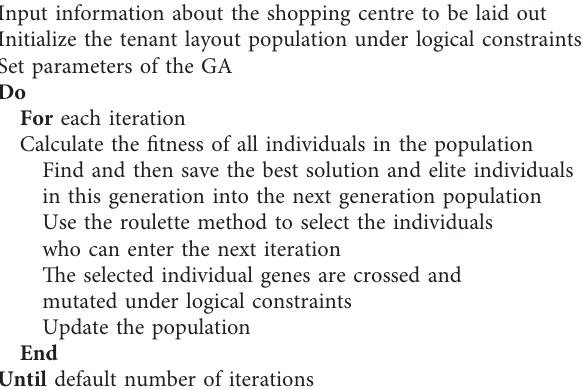
mutated under logical constraints Update the